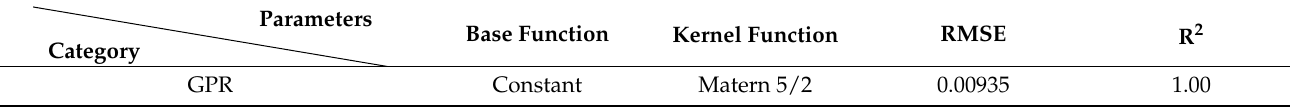
Table 4. The parameters of the model and the training